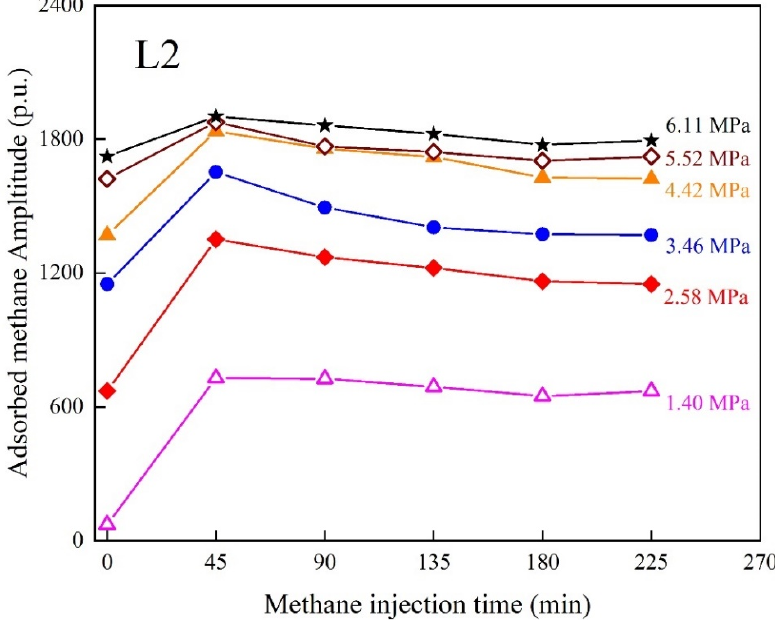
Figure 12. Relationship between adsorbed methane T 2 amplitude and injection time under six different pressures, for sample L2.